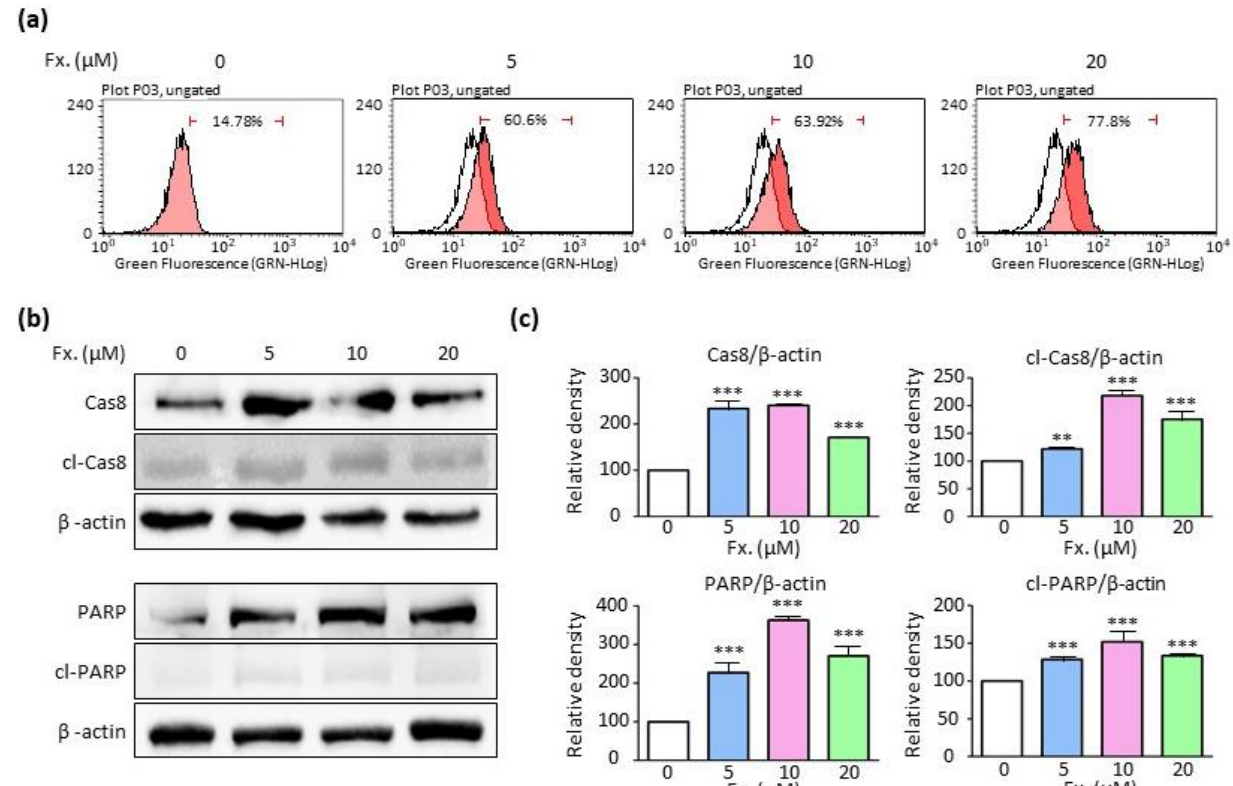
Figure 2. Fucoxanthin induces cell apoptosis via the caspase-dependent pathway. ( a ) Flow cytometry analysis showing apoptosis in CMT-U27 cells treated with fucoxanthin (0, 5, 10, and 20 µ M) for 24 h. ( b ) Western blot images showing protein expression of caspase 8, cleaved-caspase 8, PARP, and cleaved-PARP in CMT-U27 cells after fucoxanthin treatment (0, 5, 10, and 20 µ M) for 24 h. ( c ) Relative density of PARP, cleaved-PARP, caspase 8, and cleaved-caspase 8 normalized by β -actin. Fx., Fucoxanthin. Values are presented as the mean ± SD of three independent experiments. ** p < 0.01, *** p <